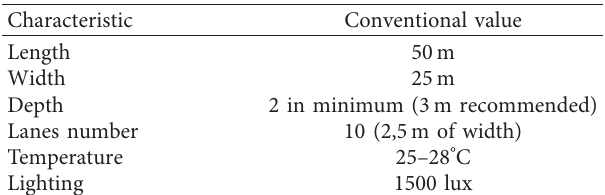
Table 1: FINA standards for the eligibility of 50 meters Olympic